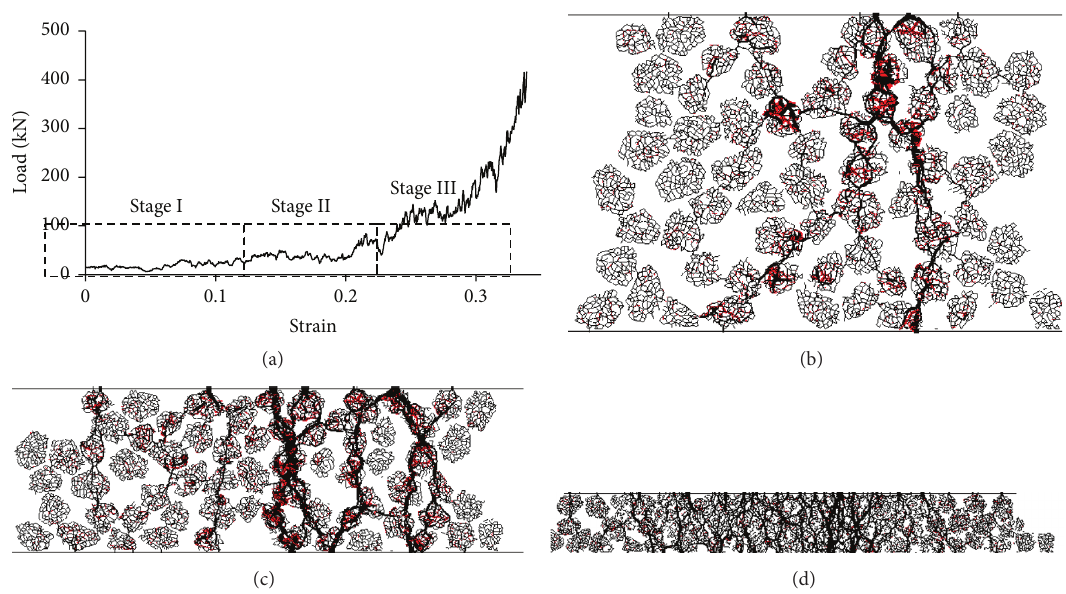
Figure 3: The mechanical properties of spoils: (a) load-strain curve of spoils under unconfined compression; (b–d) the distribution force chains in spoils during different compressing